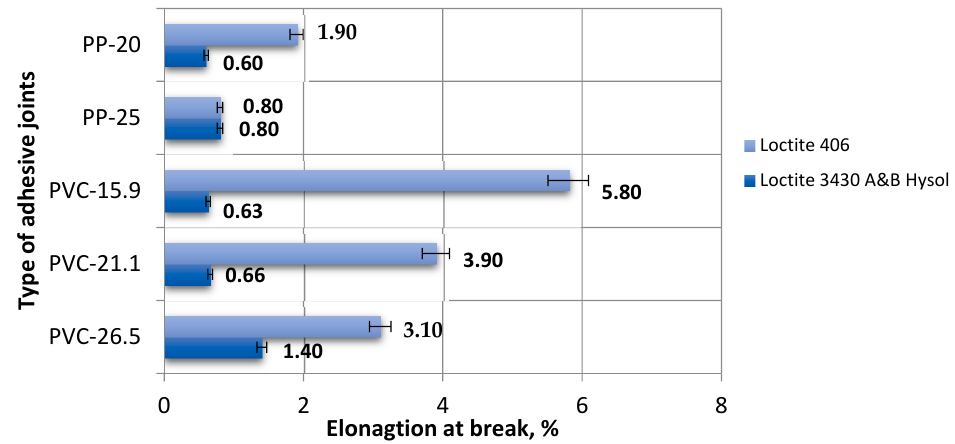
Figure 8. Elongation and break of butt-adhesive joints samples made with Loctite 3430 A&B Hysol adhesive and Loctite 406 adhesive.